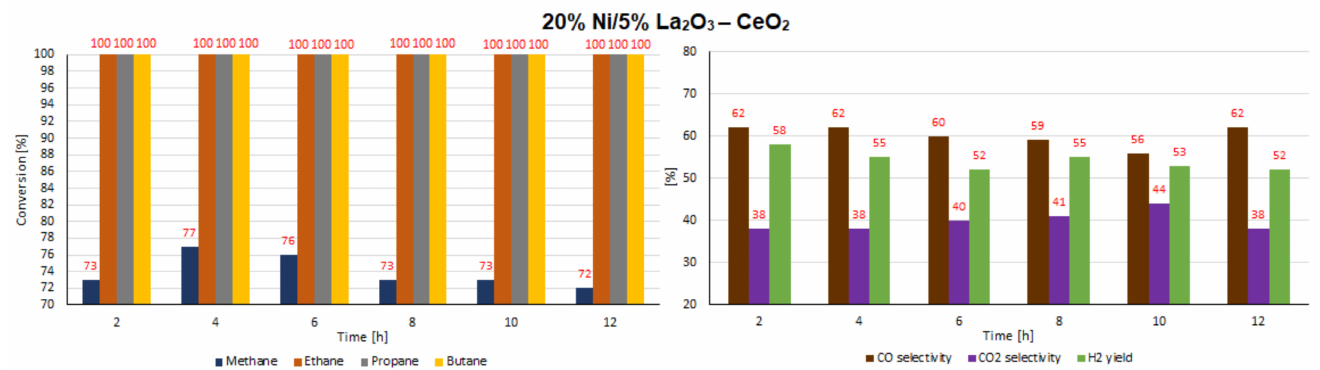
Figure 23. Results of the time-on-stream catalytic tests performed over 12 h of the OSR of LNG reaction on a 20% Ni/5% La 2 O 3 –CeO 2